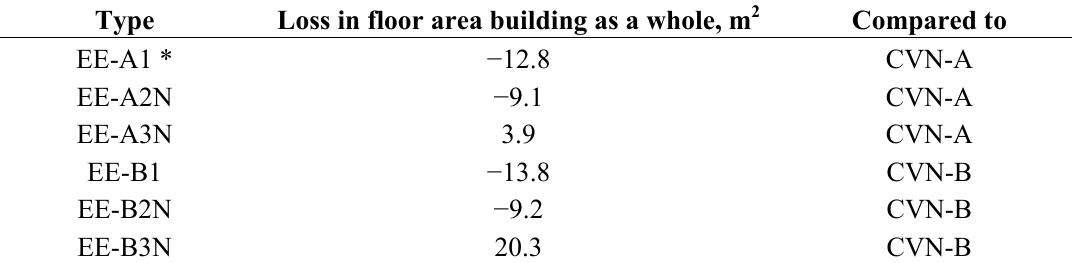
Table 9. Loss in floor area for different energy-efficient technologies, only changes in wall construction,